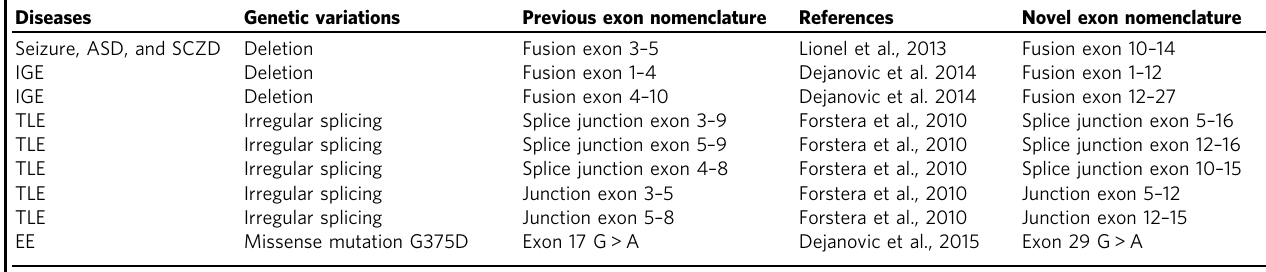
Table 1 Genetic variations and irregular splicing of GPHN characterized in patients with neurological